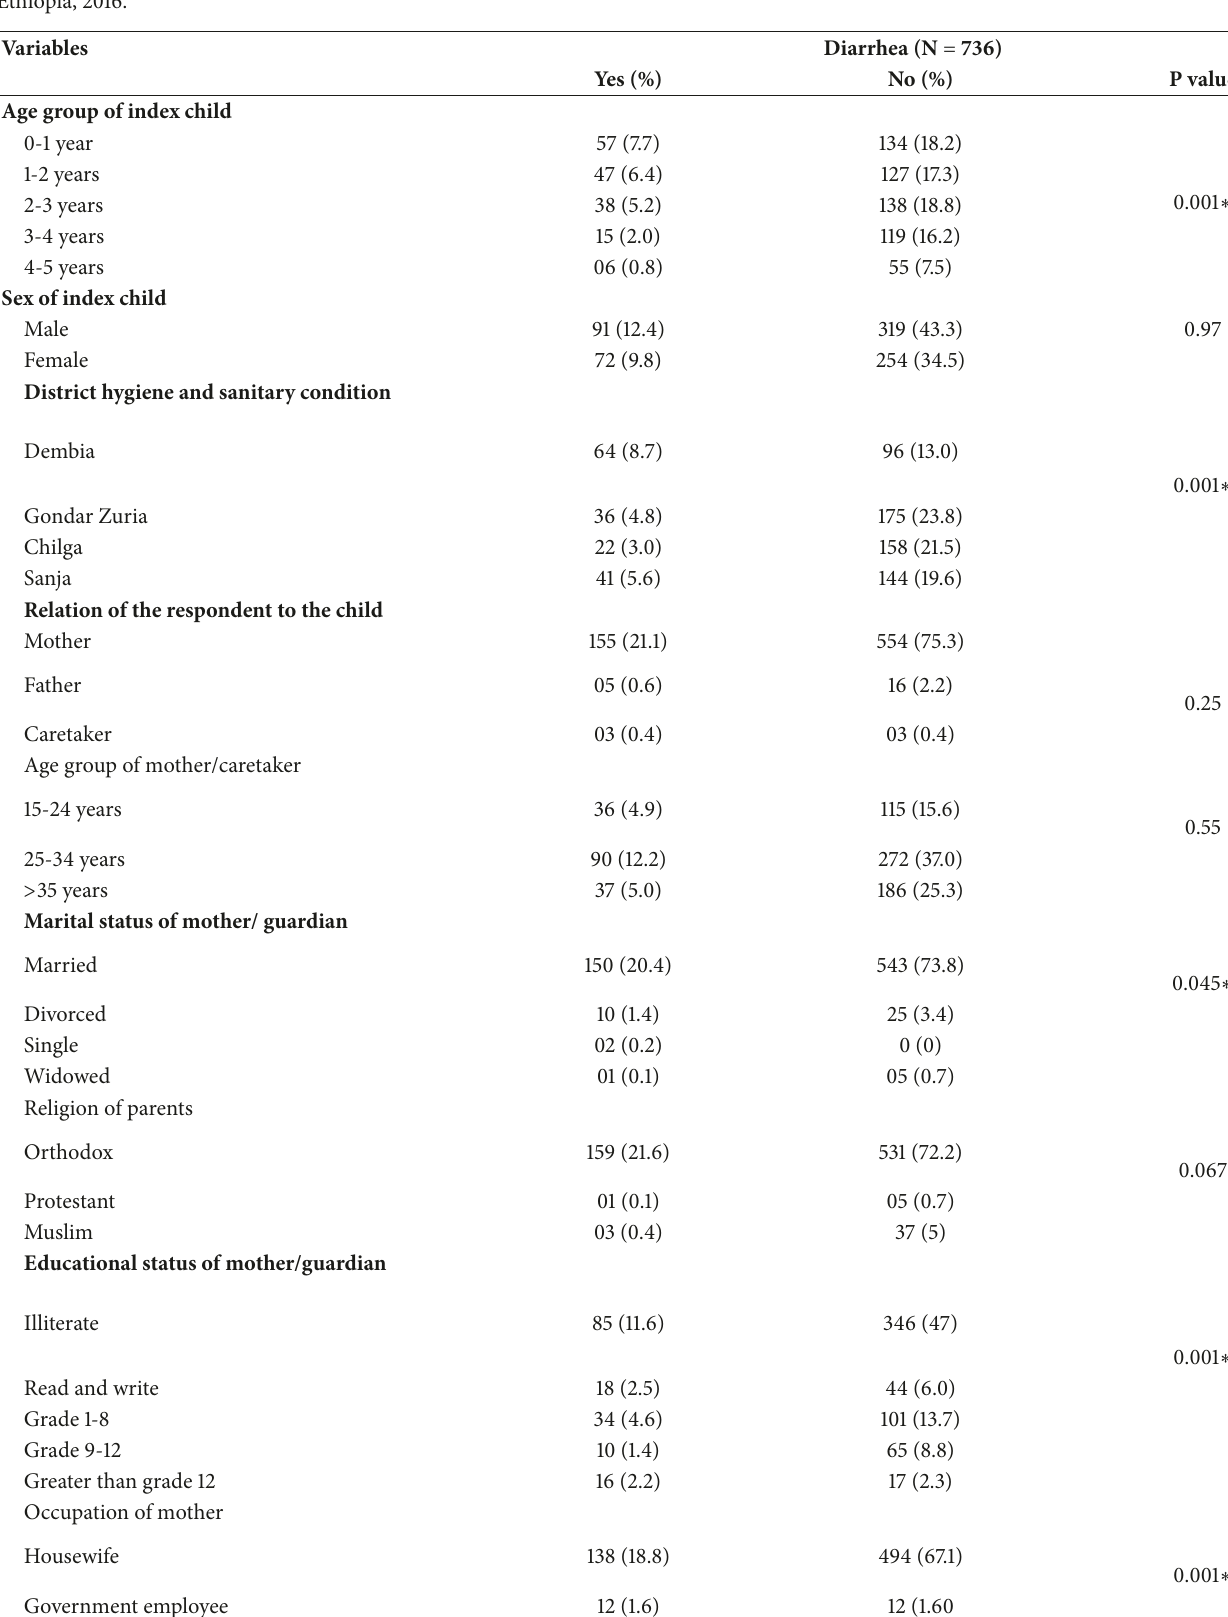
Table 1: Sociodemographic characteristics of respondents among under-five children in rural areas of North Gondar Zone, Northwest Ethiopia,